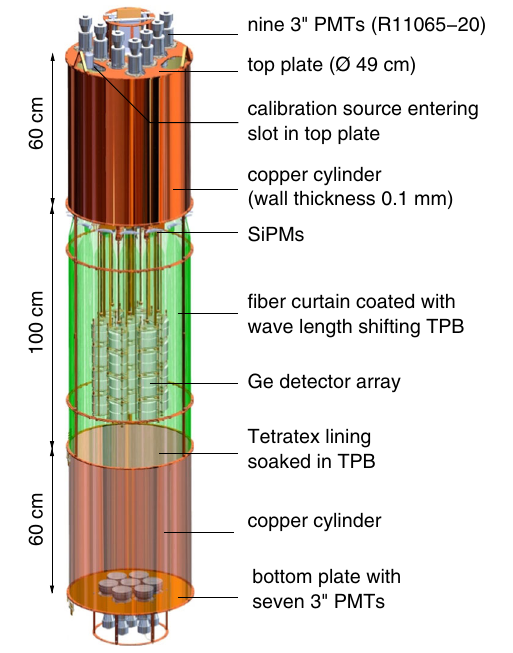
Fig. 9 The Ge detector array enclosed by the LAr veto